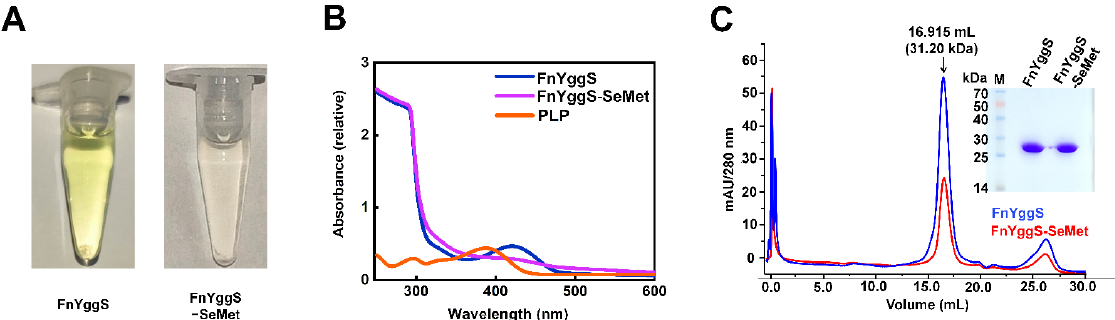
Figure 1. Characterization of PLP binding to FnYggS. ( A ) The FnYggS and FnYggS-SeMet solutions were yellow and colorless, respectively. ( B ) Native FnYggS exhibited an absorption peak at 425 nm due to PLP binding, whereas FnYggS-SeMet did not exhibit an absorption peak, indicating the absence of PLP binding. The absorption peak of PLP was seen at 380 nm. ( C ) Purified native and SeMet-derivatized FnYggS solutions and size exclusion chromatography results. Both proteins existed as monomers in solution.